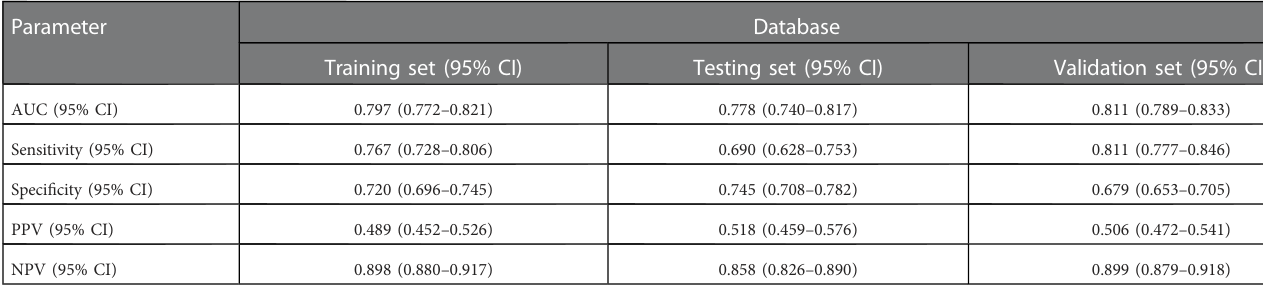
TABLE 3 Construction and validation of the prediction model.